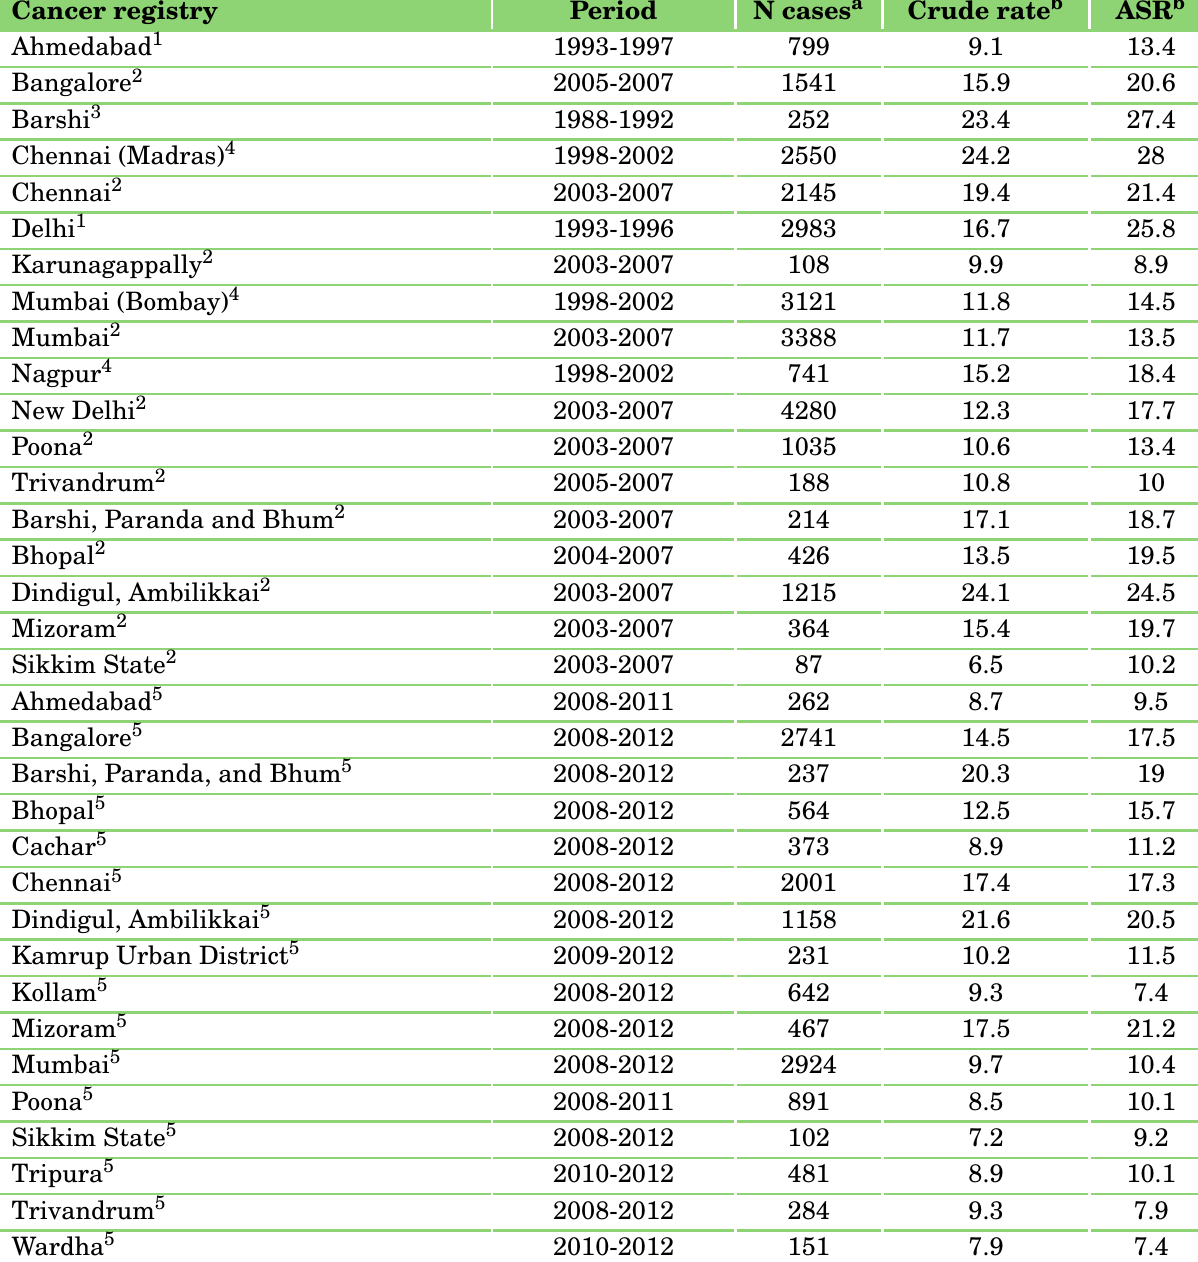
Table 3: Cervical cancer incidence in India by cancer